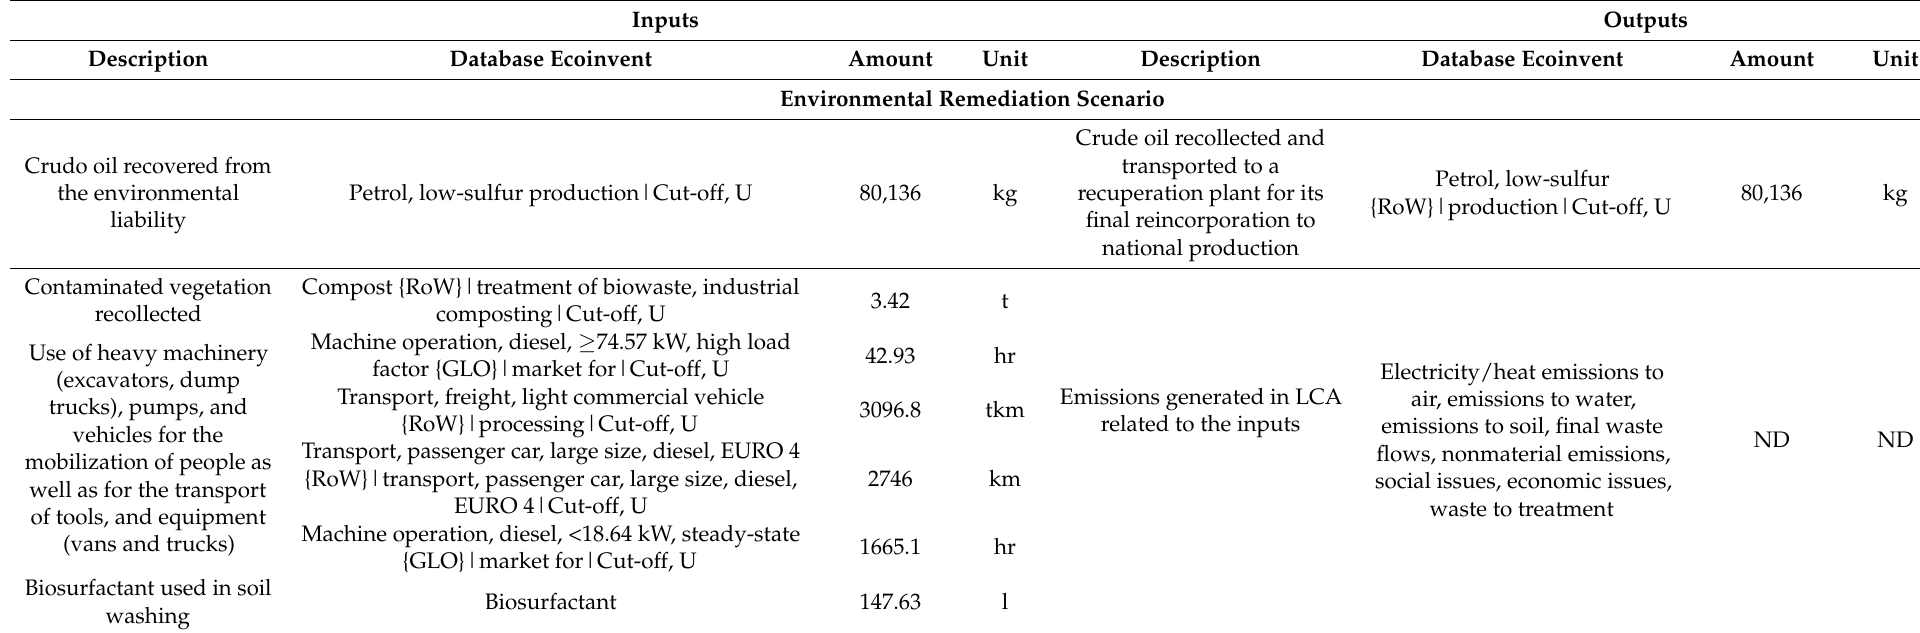
Table 2. Life cycle inventory for the environmental remediation and non-action